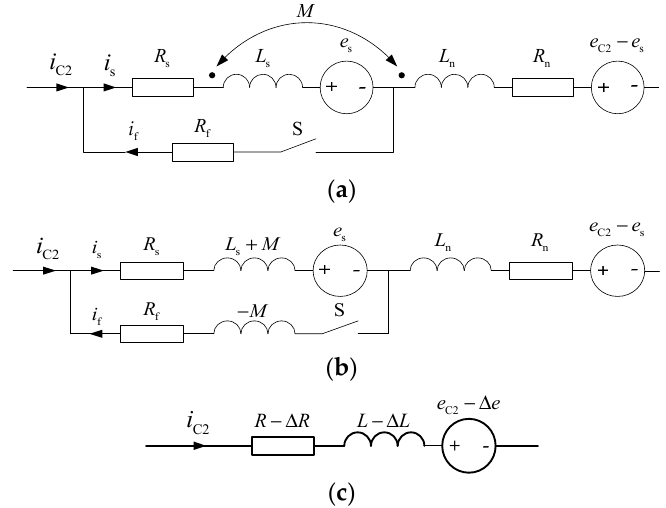
Figure 5. Circuit model diagrams of the phase with ISCF: ( a ) Equivalent circuit; ( b ) Decoupling equivalent circuit; ( c ) Simplified